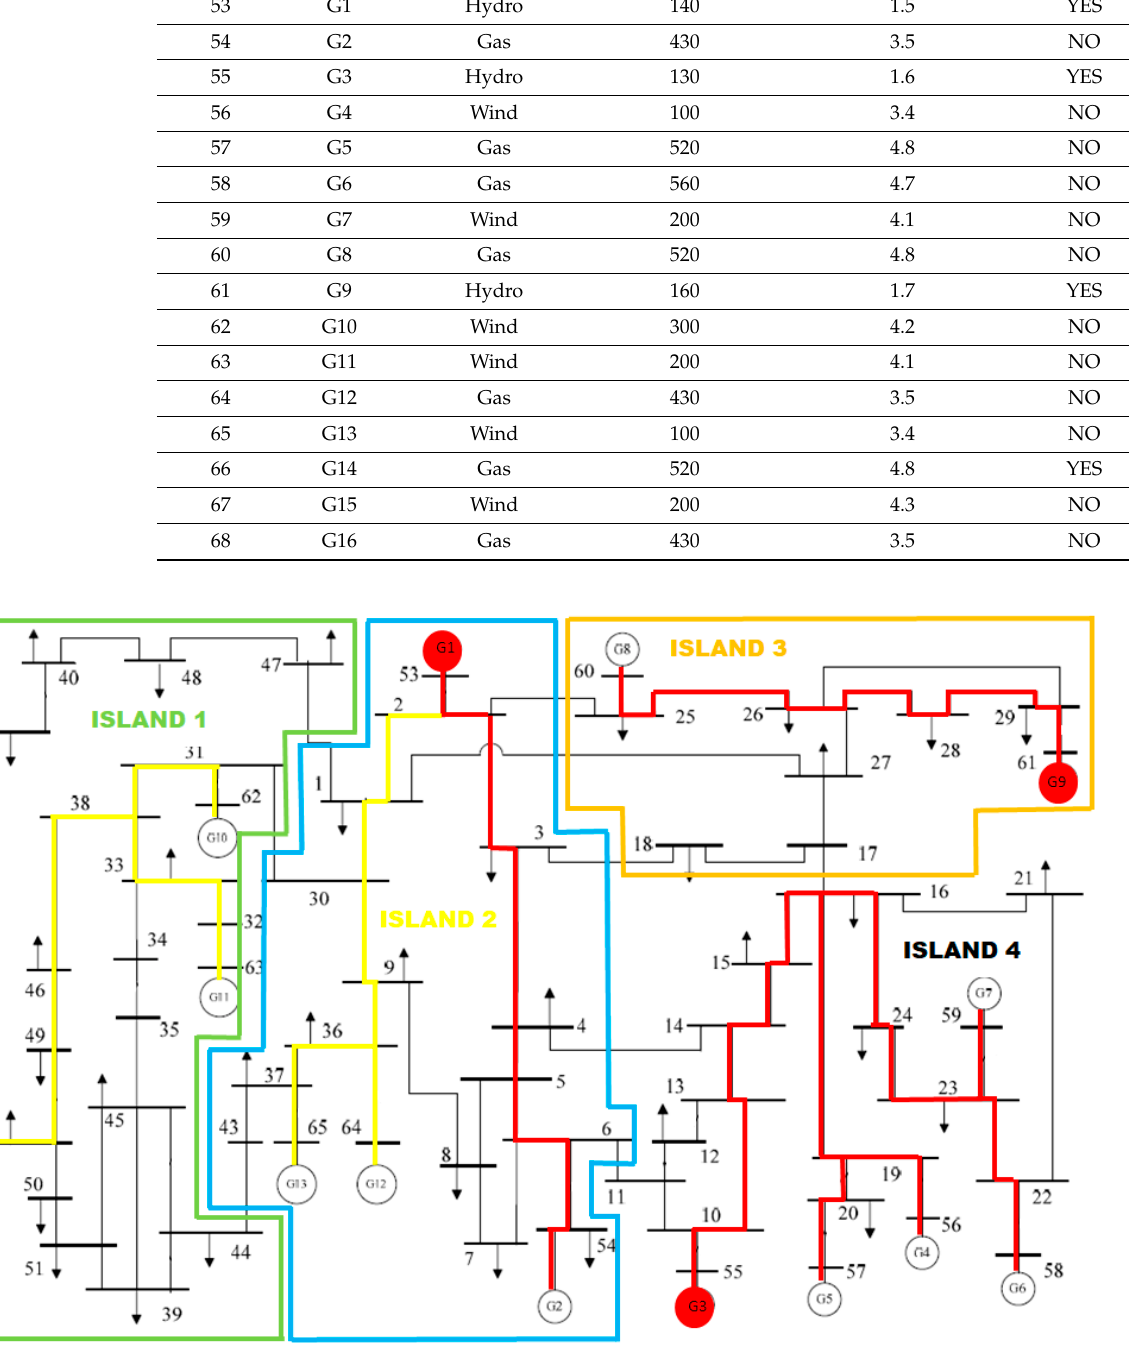
Figure 10. Optimal restoration path using the A* Algorithm for the IEEE-68 bus system.